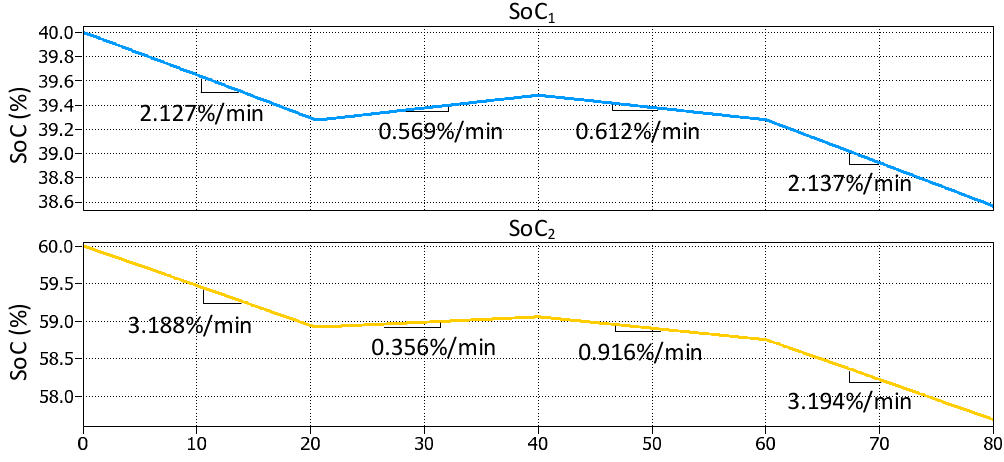
Figure 17. S oC of battery 1 and battery 2 during mode switching. Figure 17. SoC of battery 1 and battery 2 during mode